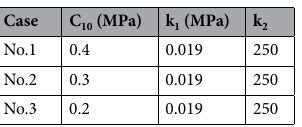
Table 5. Holzapfel material constants in different cases.